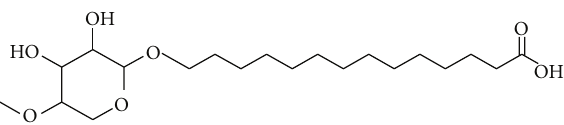
Figure 5: Structure of biosurfactant predicted from IR and NMR ( 1 H & 13 C), LCMS, and GCMS spectrum.